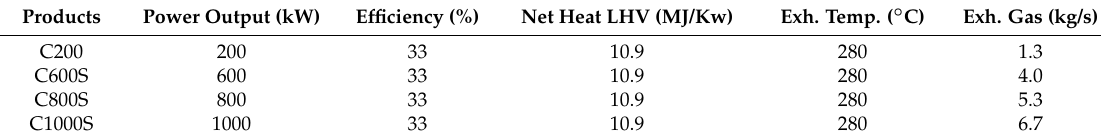
Table 1. Specifications of the commercial micro gas turbines manufactured by Capstone Turbine Corporation. Products Power Output